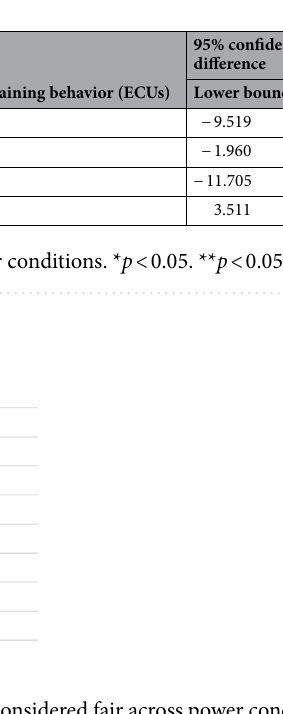
Figure 3. Share of self-allocated surplus (in ECUs) that is considered fair across power conditions. Error bars represent standard error of the mean. Significant difference between equal-DP and large-DP conditions is represented by asterisks: ***p <